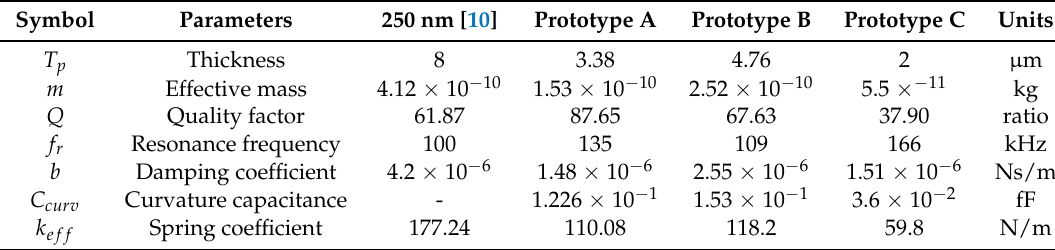
Table 3. Summary of parameters for each